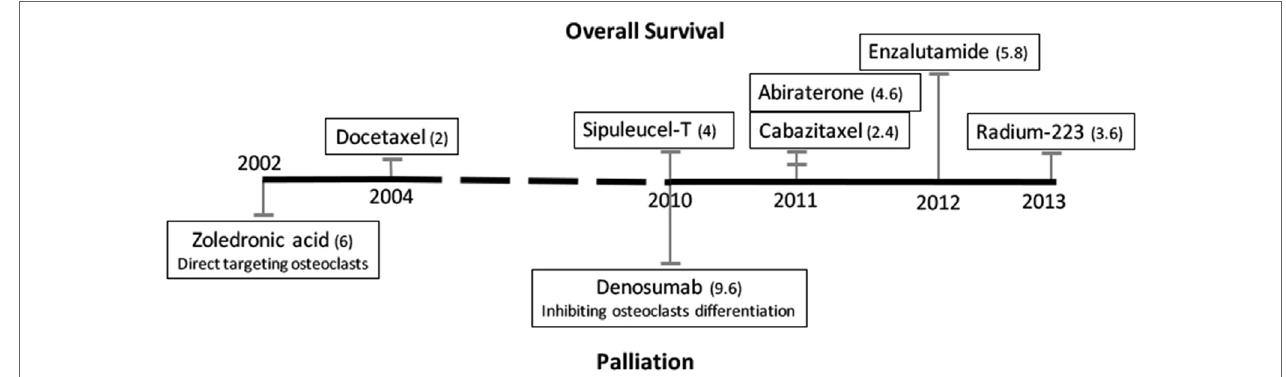
FigURe 1 | Time line of FDA-approved treatments for patients with castration-resistant prostate cancer bone metastases. Treatments that improve patients’ overall survival are listed above the black line, and palliation treatments are listed below. The numbers in parentheses are median months of overall increased survival or median months delayed to first detection of skeletal-related events,